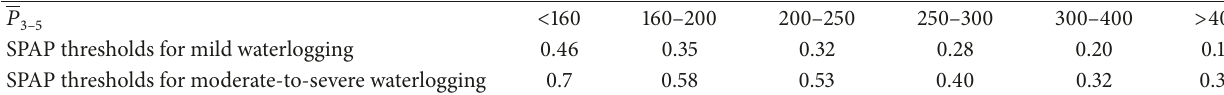
Table 2: WPI thresholds for winter wheat in the study area.